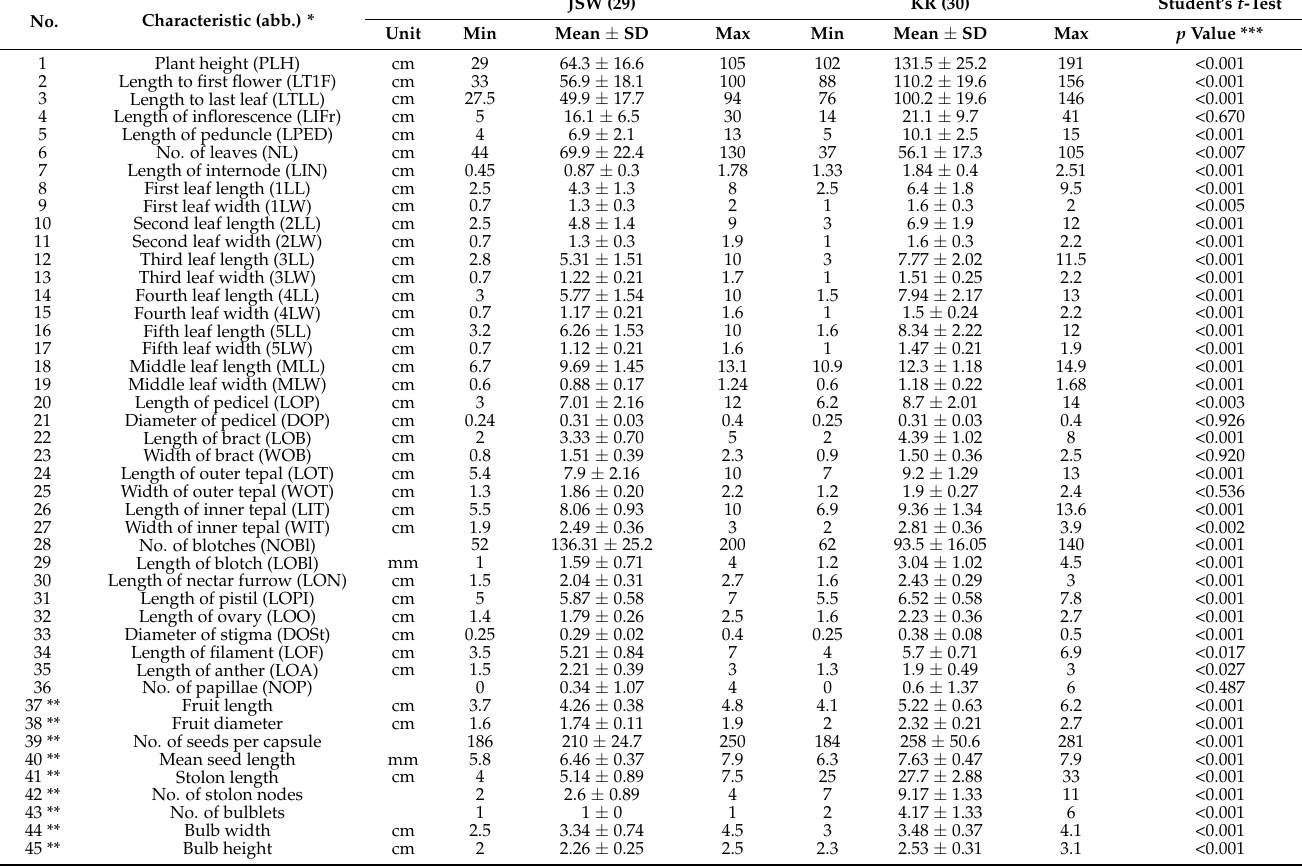
Table 2. Summary of morphological characteristics of JSW and KR groups of L. leichtlinii